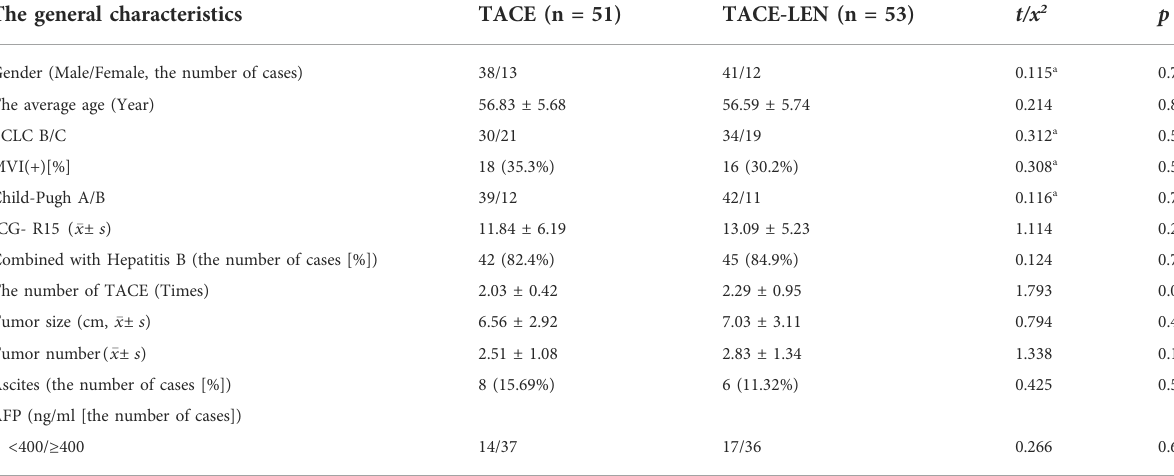
TABLE 1 Comparison of the general characteristics between the two groups of patients.